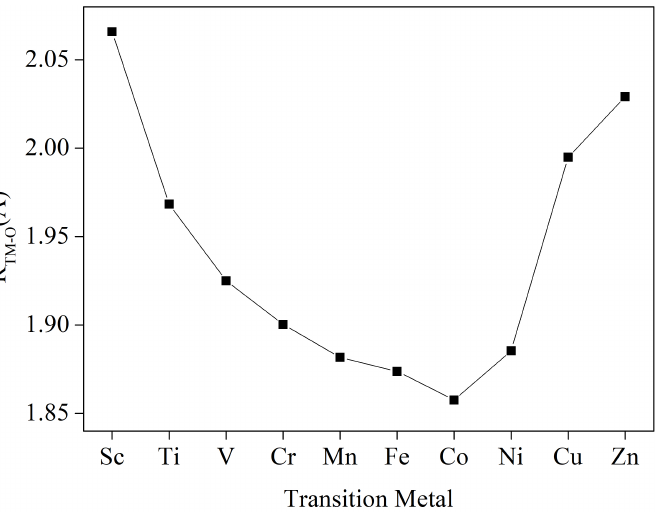
Figure 2. Bond length of the metal atom to the nearest O atom in the TM-THQ